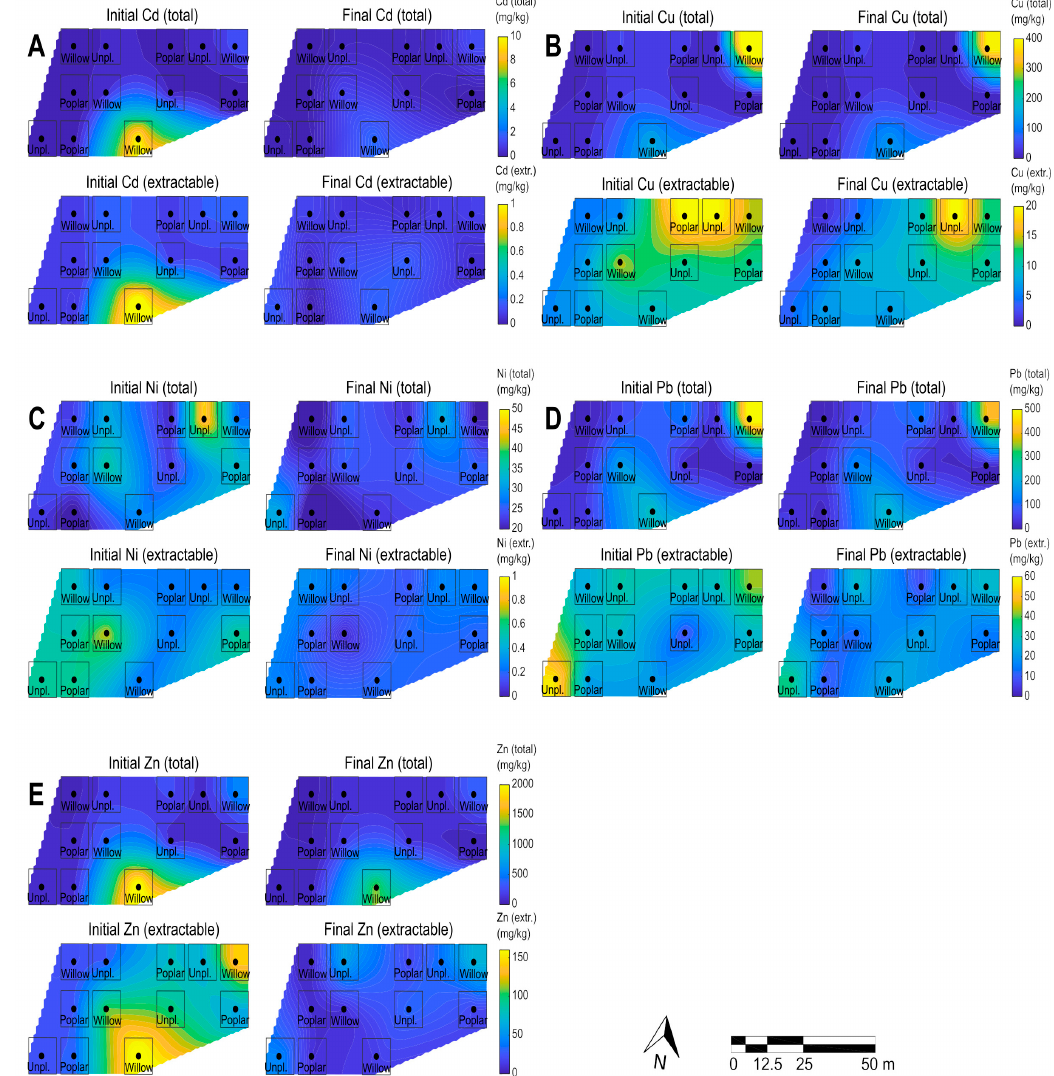
Figure 3. Temporal evolution pattern of total and DTPA-extractable trace element concentrations in the soil at the experimental site for each treatment. Comparisons are made between initial (2015) and final (2018) values for Cd ( A ), Cu ( B ), Ni ( C ), Pb ( D ) and Zn ( E ). The 2D maps were obtained by assigning the value observed from each parcel to the midpoint of the respective parcel. The points were spatially interpolated with a natural neighbor method over a 100-by-100 point grid.